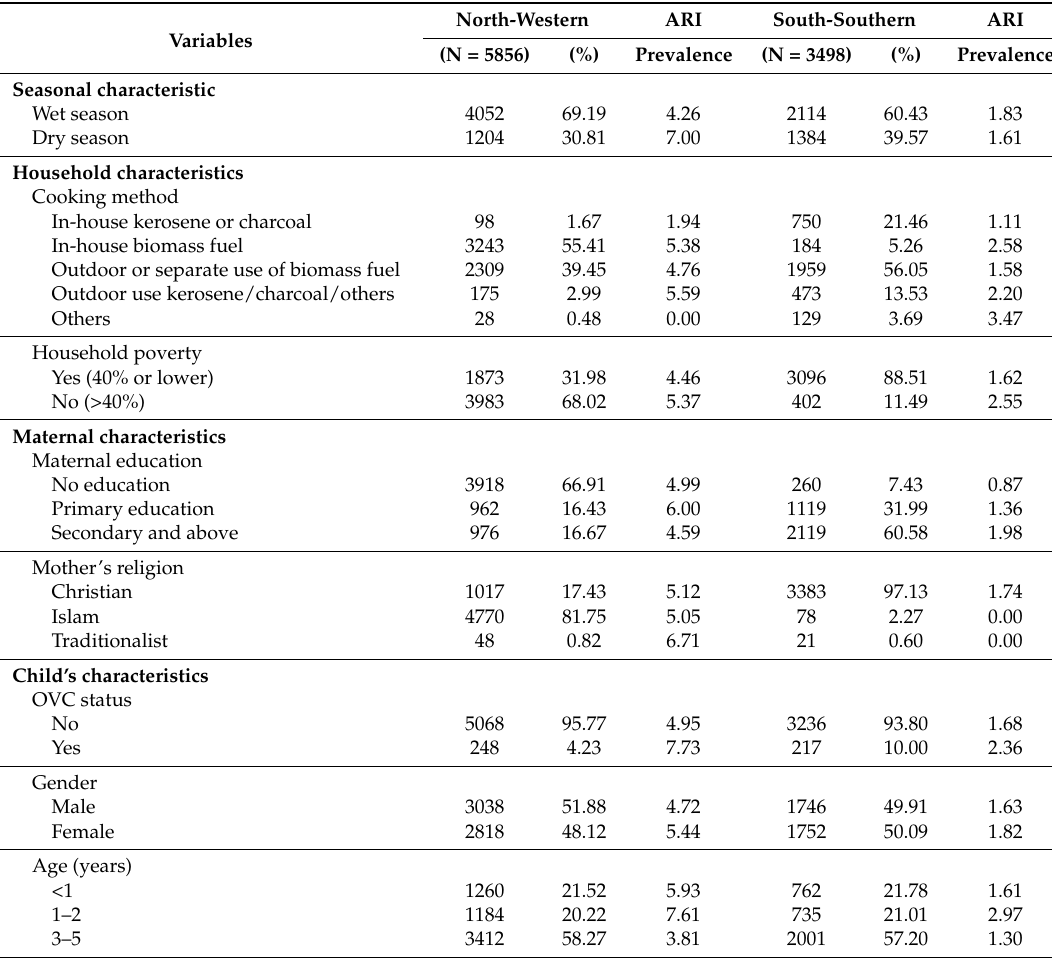
Table 1. Relationship between children and household variables and the likelihood of symptoms of acute respiratory infection (ARI) among Nigerian preschool children from the North-Western and South-Southern communities, 2013